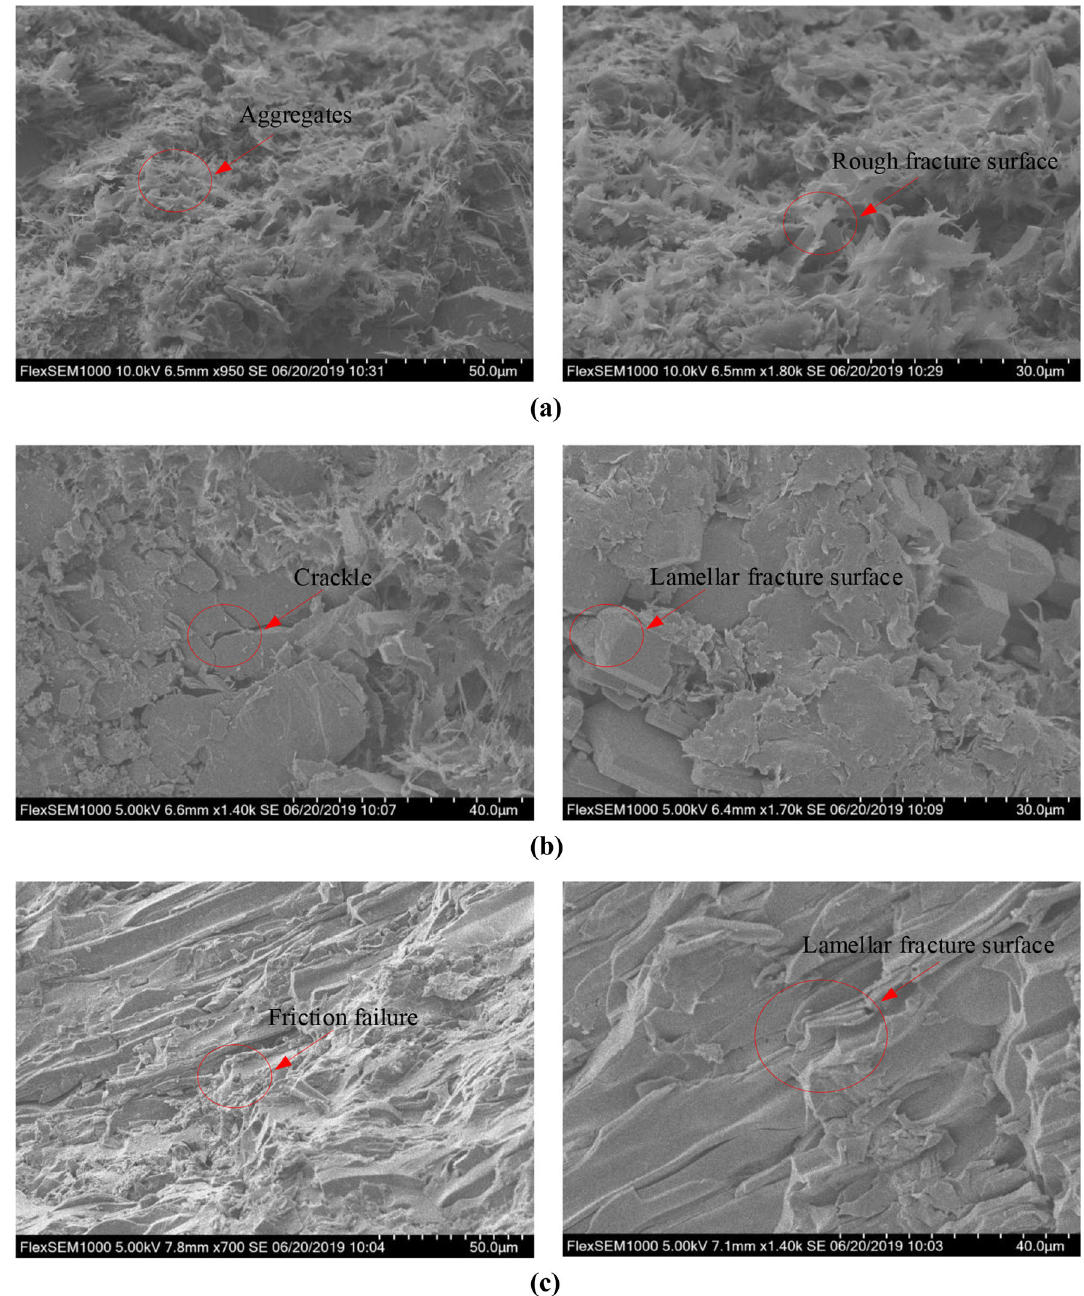
Fig. 5 SEM images of fractured precracked rock specimens with crack dip angles of a 60 (cid:3) , b 45 (cid:3) , and c 30